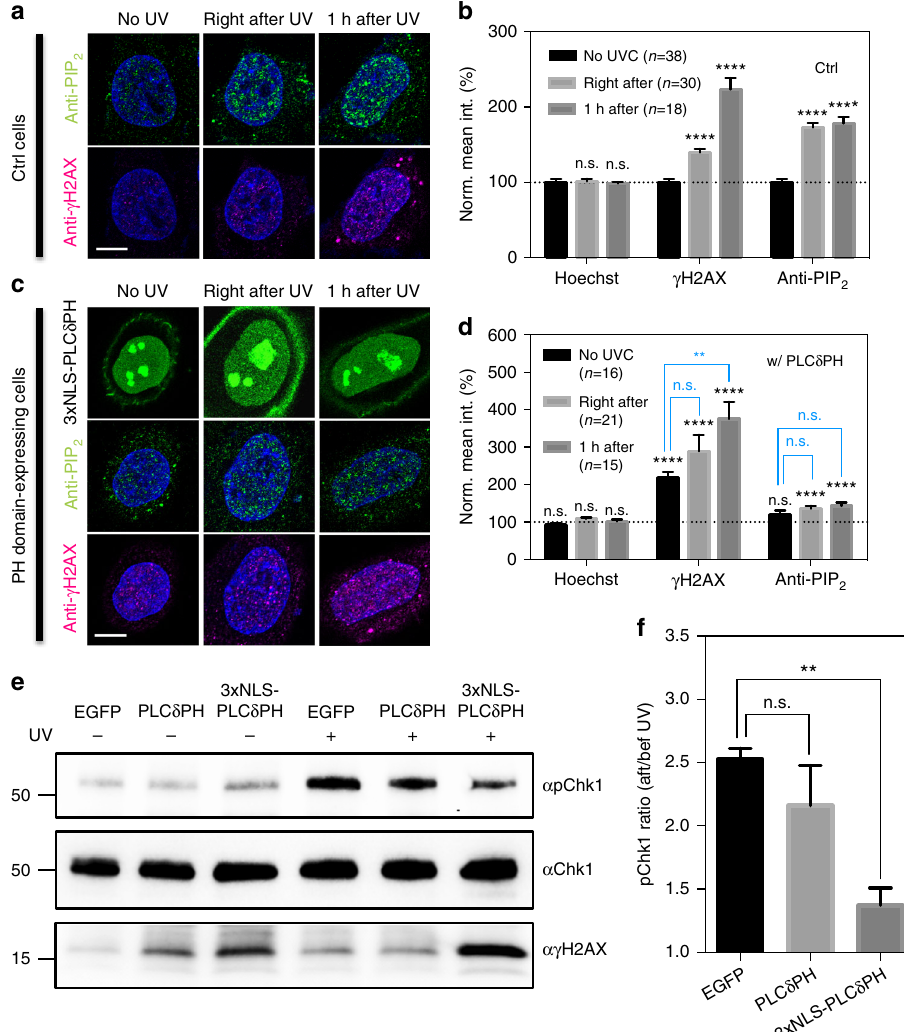
Fig. 1 Nuclear PIP 2 /PIP 3 level increases upon DNA damage induction. a Confocal optical slices showing nuclear PIP 2 speckles and γ H2AX foci in control U2OS cells as revealed by immunostaining before and after being exposed to UV. Secondary antibody labeling PIP 2 and γ H2AX was conjugated with Alexa Fluor-546 and Alexa Fluor-647, respectively. b Corresponding quanti fi cation of panel A showing the normalized mean fl uorescence intensity of Hoechst 33342, PIP 2 and γ H2AX within the nucleus. c Same anti-PIP 2 and anti- γ H2AX staining for U2OS cells transfected with 3xNLS-PLC δ PH before and after being exposed to UV. d Corresponding quanti fi cation of panel c . Results were normalized to the signal intensities of non-UV treated, non-transfected cells as shown in panel B. Symbols in black indicated t -test p -values when comparing it to the signal intensity of non-UV treated, non-transfected cells in panel b. Symbols in blue indicated t -test results when comparing it to the non-UV treated PLC δ PH-expressing cells. Please refer to Supplementary Figure 1 for similar results obtained from cells with chemical-induced DNA damage. e Western blots showing suppressed Chk1 activation and increased γ H2AX level in MEFs expressing 3xNLS-PLC δ PH-EGFP, but not EGFP or cytoplasmic PLC δ PH-EGFP upon global UV irradiation. Numbers on the left indicated the molecular weight of the ladder. Cells were exposed to UV for 2 min and harvested after 1hr recovery in an incubator. f Corresponding pChk1 ratio with and without being exposed to UV. Scale bar 10 μ m. Data are representative of three independent experiments. Error bars represent mean ± s.e.m in all panels. Student ’ s t -test, * p < 0.05; ** p < 0.01; *** p < 0.001; **** p < 0.0001. n.s. represents not signi fi